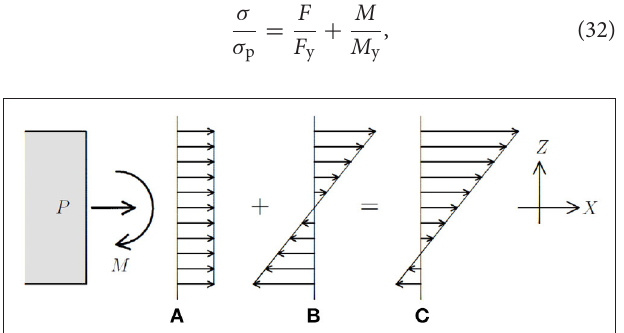
FIGURE 2 | Superposition of stress in a beam subject to combined axial load P and bending moment M . The cross-sectional area is A , on which the stress distribution due to P alone is shown in (A) , that due to M is shown in (B) , and the superposition of the two is shown in (C)